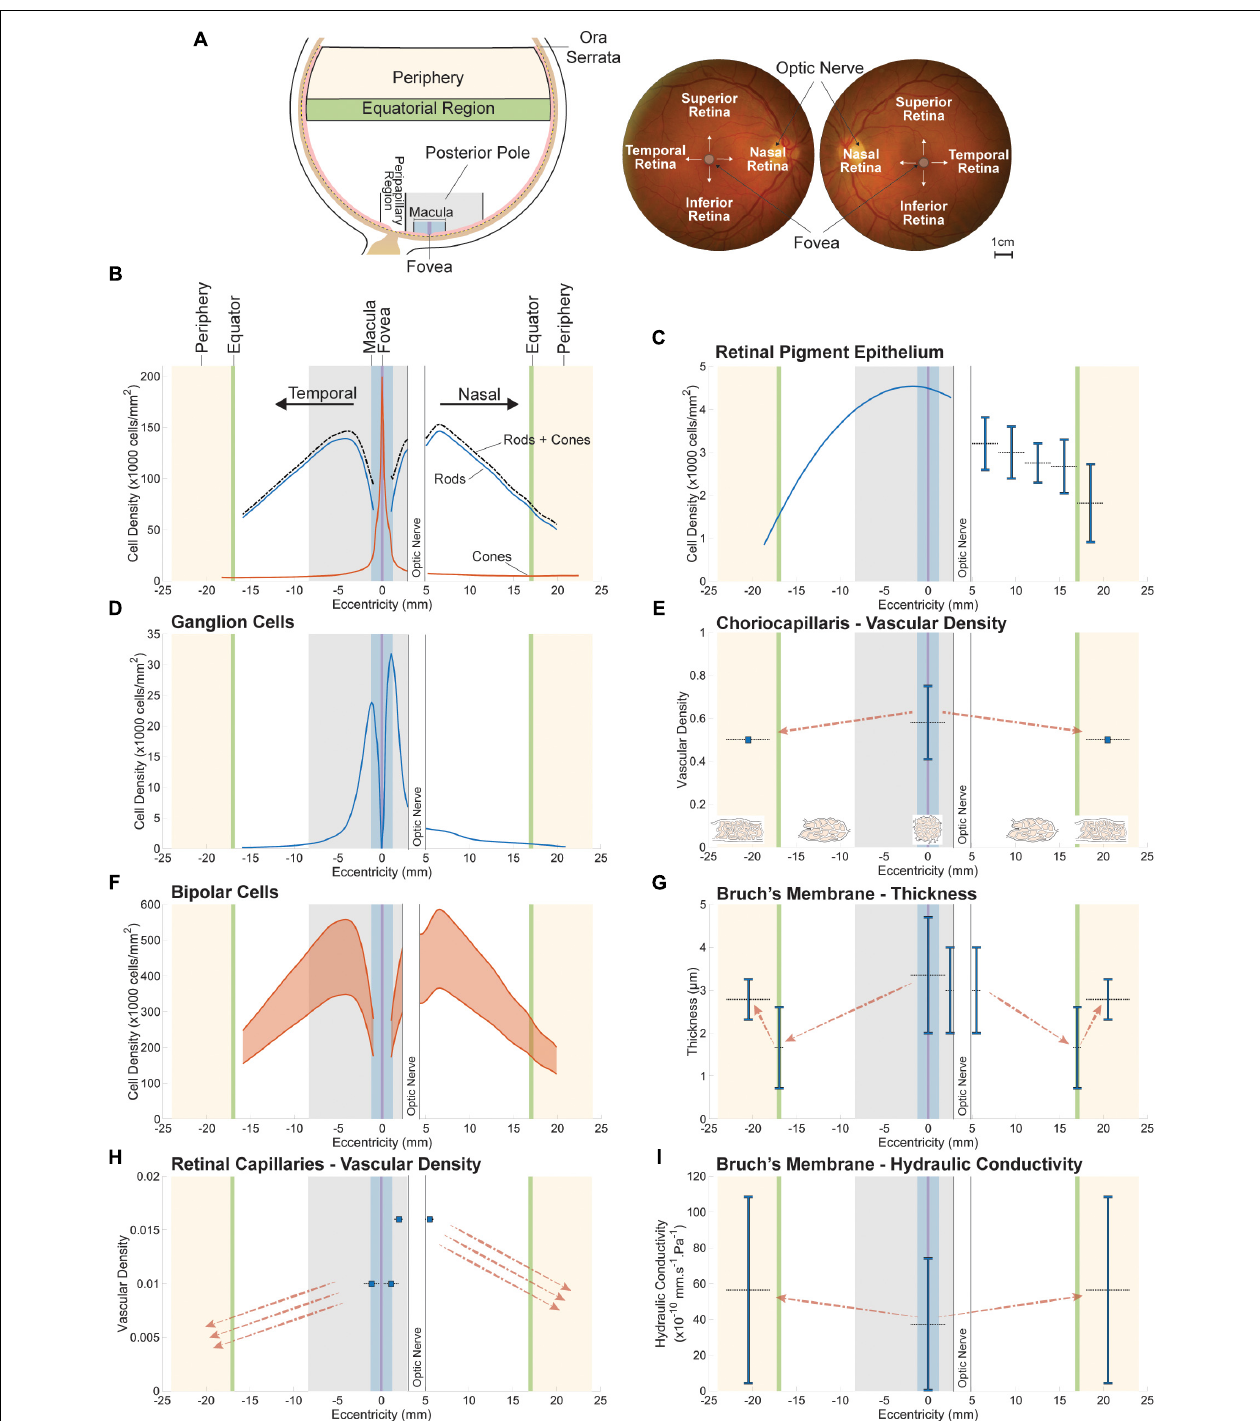
FIGURE 4 | Spatial variations in retinal neuron populations (B,D,F) and in the key structures of their respective metabolite delivery systems (C,E,G–I) . The approximate location of sampled retinal regions and their associated denomination is described in (A) . Terminologies vary between studies; the ones employed here are consistent with the main text. Plotted data were collected from publications listed in Supplementary Table 1 . All spatial variations are displayed along the nasal-temporal axis as illustrated in (B) . Reported values are plotted as vertical line segments (ranges) or single points, and the approximate region they apply to is delineated using horizontal dashed lines. Dashed arrows indicate qualitatively reported trends. The density of bipolar cells (F) is plotted as a range inferred from approximate ratios between their density and that of their respective photoreceptor type. The maximal vascular density of retinal capillaries (H) appears to overlap with the highest density of bipolar (F) and ganglion (D) cells. Bruch’s membrane is thickest at the fovea (G) , where photoreceptor density (B) and choriocapillaris vascular density (E) are highest.